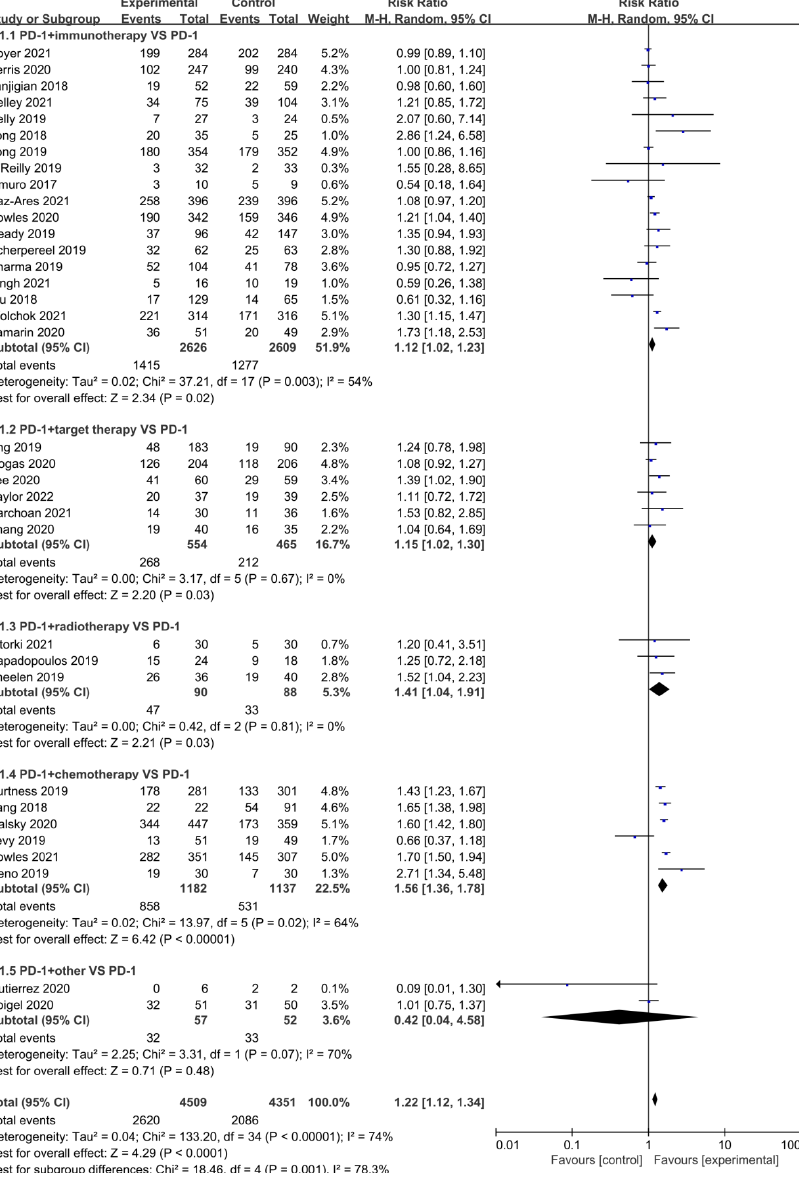
Figure 3. Forest Plot of the Risk ratio of DCR based on therapeutic schedules: anti-PD-1/PD-L1 versus combination therapy (immunotherapy, targeted therapy, radiotherapy, chemotherapy, and other drugs). Boyer 2021 [12] , Ferris